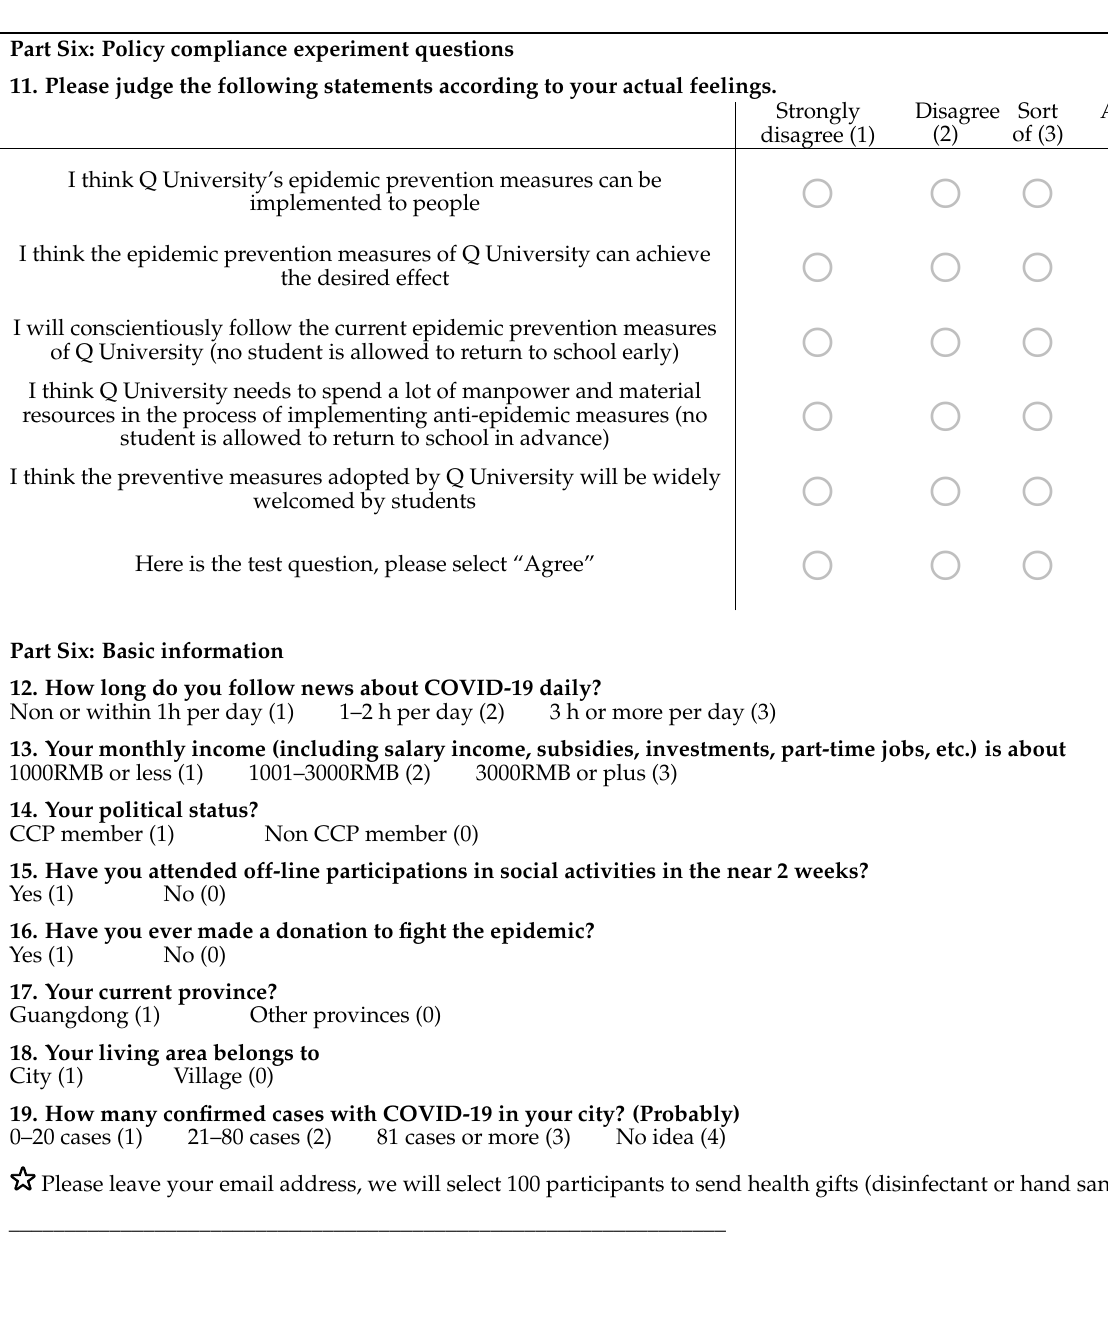
Table A3. Multiple Regression Analysis of